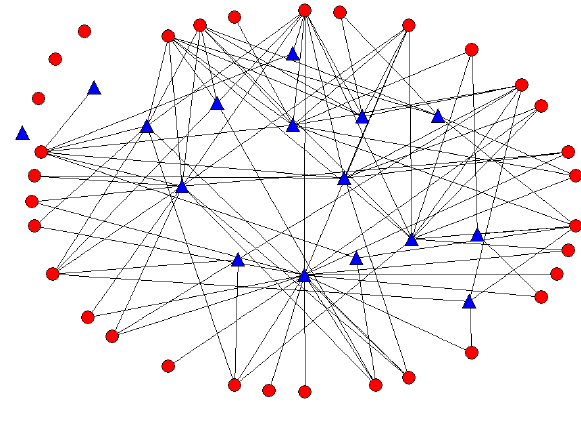
Figure 5: Communicative network institutions-firms